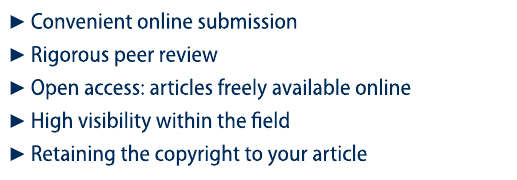
97. Young J, Park PY (2013) Benefits of small municipalities using jurisdiction- specific safety performance functions rather than the highway safety Manual ʼ s calibrated or uncalibrated safety performance functions. Can J Civ Eng 40:517 –